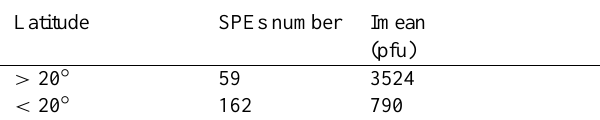
Table 2. SPEs number and Imean in latitudes > 20 ◦ and < 20 ◦ . Latitude SPEs number Imean (pfu) > 20 ◦ 59 3524 < 20 ◦ 162